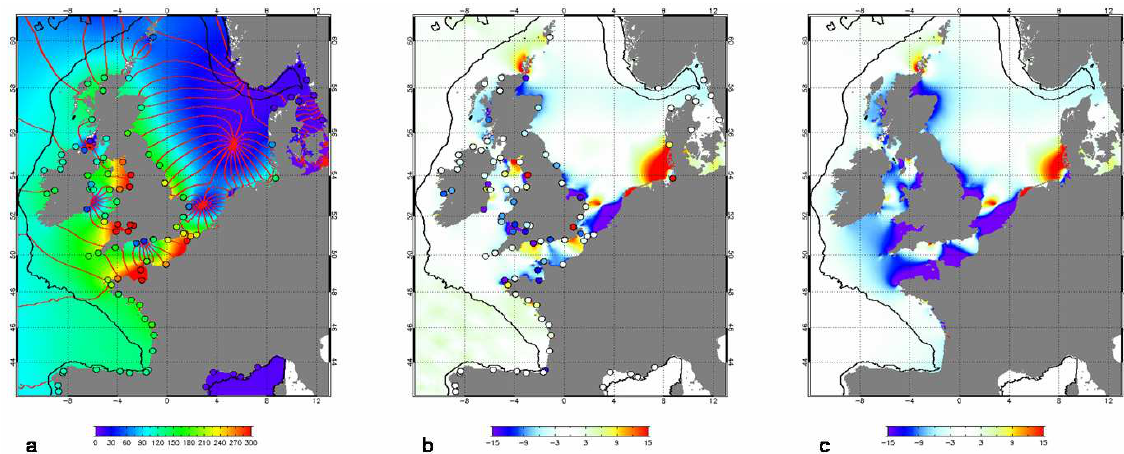
Figure 3. a) Amplitude in cm (color) and phase (red lines) of modeled M2 tidal constituent. Overplotted filled dots are the M2 observed harmonic constants at the various tide gauges used for quantitative assessment. b) M2 Amplitude difference (cm) between the FES2004 solution ( Lyard et al. , 2006) and the model. Overplotted filled dots represent amplitude and phase differences between tide gauges and the model. c) Same as b) but in the barotropic experiment (runbt). On each figure, the black line indicates the 200m isobath.